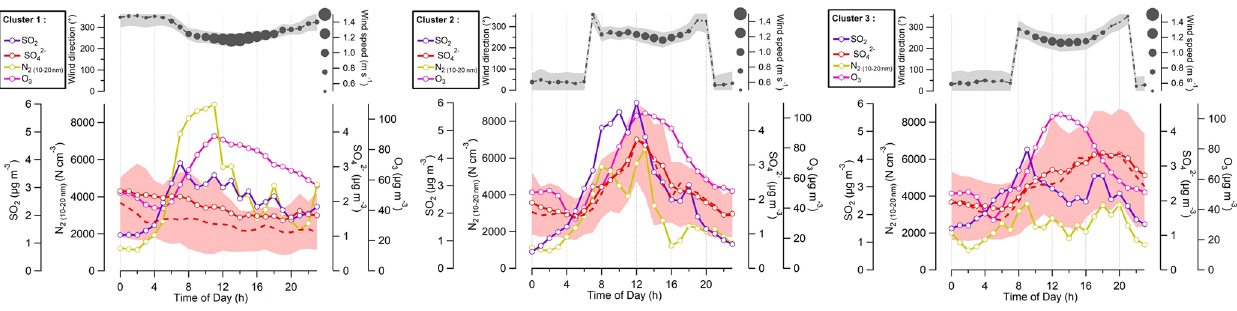
Figure 12. Diurnal cycles of SO 2 − , SO 2 , N 2(10–20nm) and O 3 for the three clusters in summer 2017. Solid lines denote mean profiles, red 4 dashed line is the median and red shaded area is the 25th–75th percentile range for SO 2 − . The average diurnal cycles for wind direction are 4 also shown in the upper panels, with the size of dots depending on wind speed and the grey shaded area representing ± the standard deviation of